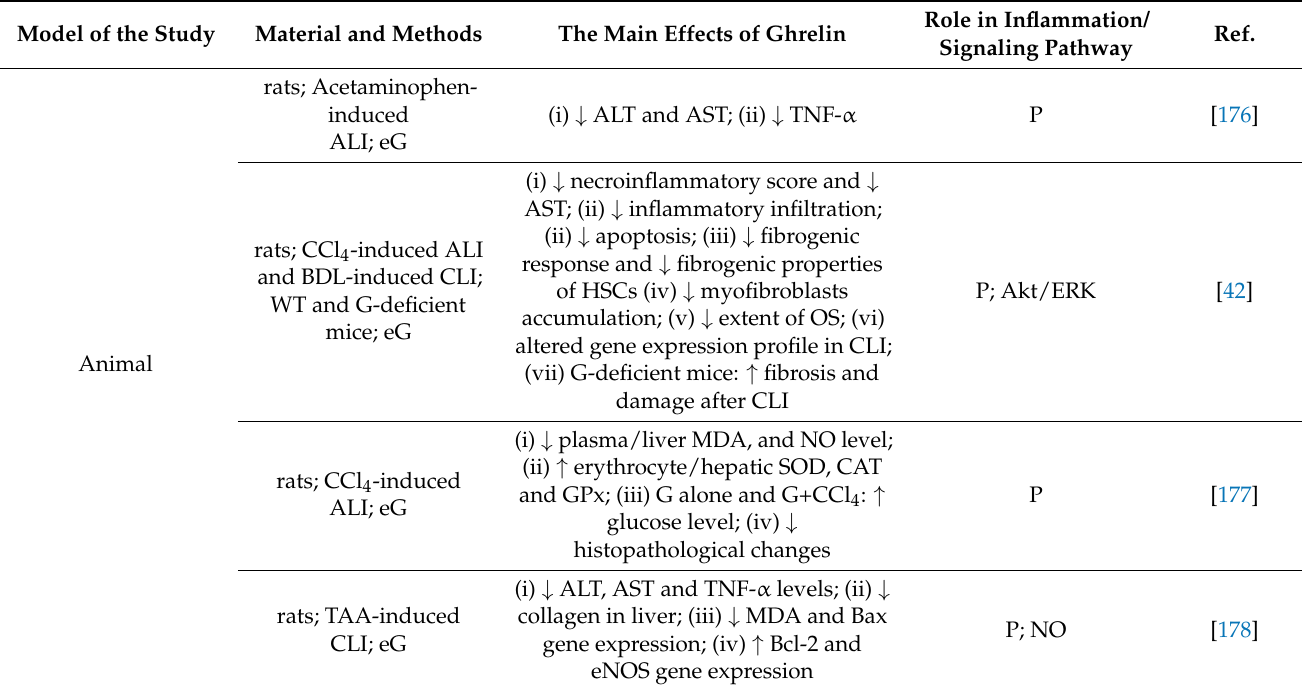
Table 4. Role of Ghrelin in Various Types of Liver Injury—the Animal and in vitro Study Models. Model of the Study Material and Methods The Main Effects of Ghrelin